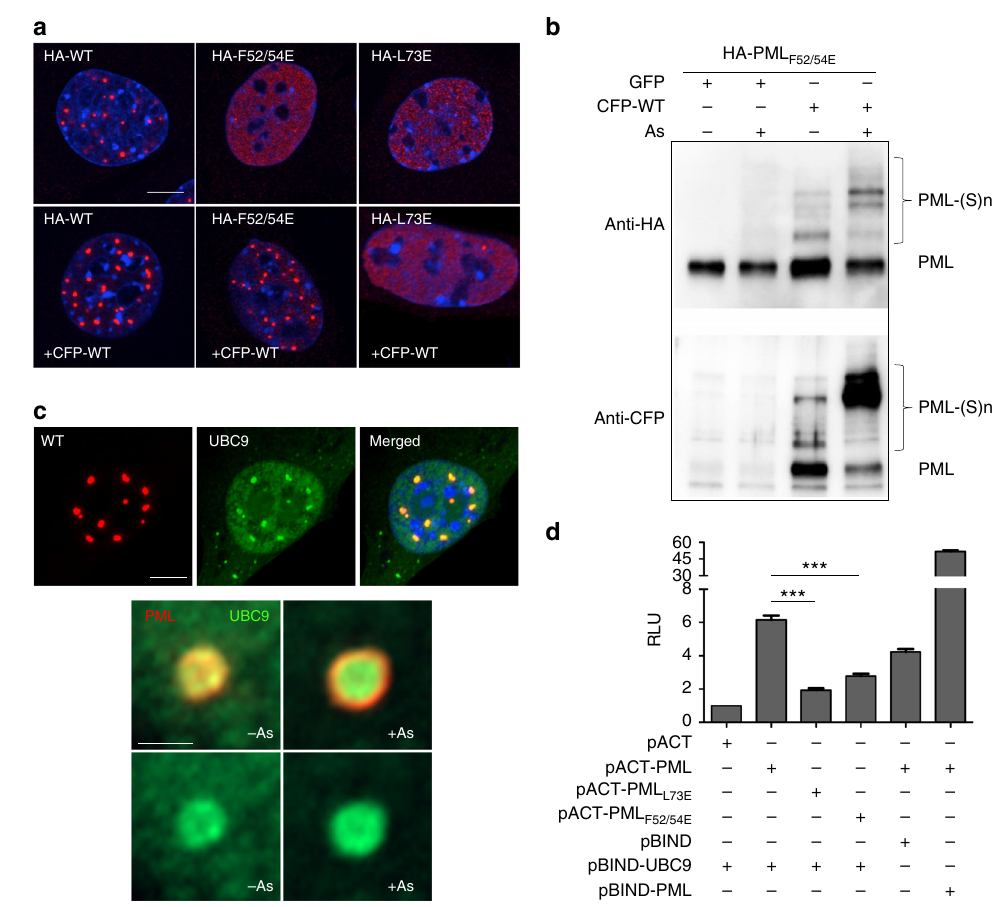
Fig. 5 PML tetramerization controls NB formation and PML sumoylation. a Immortalized Pml − / − MEFs were transduced with MSCV virus expressing PML or its mutants and subsequently transduced or not with CFP-PML. PML NBs were monitored by immuno- fl uorescence using anti-HA antibody (red). DAPI is in blue. Scale bar is 5 μ m. b Immortalized Pml − / − MEFs obtained in a were treated with As 2 O 3 (10 – 6 M, 1 h) and extracts were analyzed by Western blot using anti-HA or anti-CFP. PML and its sumoylated forms are indicated. c Co-localization of stably expressed HA-PML (red) and UBC9-GFP (green) basal condition (left) or upon 10 − 6 M As 2 O 3 for 1h (right). DAPI is in blue. Middle and bottom: Visualization of PML and UBC9 localization with/without arsenic. Scale bars are 5 μ m (top) and 0.5 μ m (middle and bottom). d Mammalian two-hybrid: relative luciferase activities (RLU) were used to estimate the interaction between UBC9 and PML/mutants. Statistical signi fi cance is indicated. All experiments have been done at least with three independent replicates. Values are means ± S.E. *** p < 0.001 are used to show statistically signi fi cant between recombinant derivatives. pACT-PML and